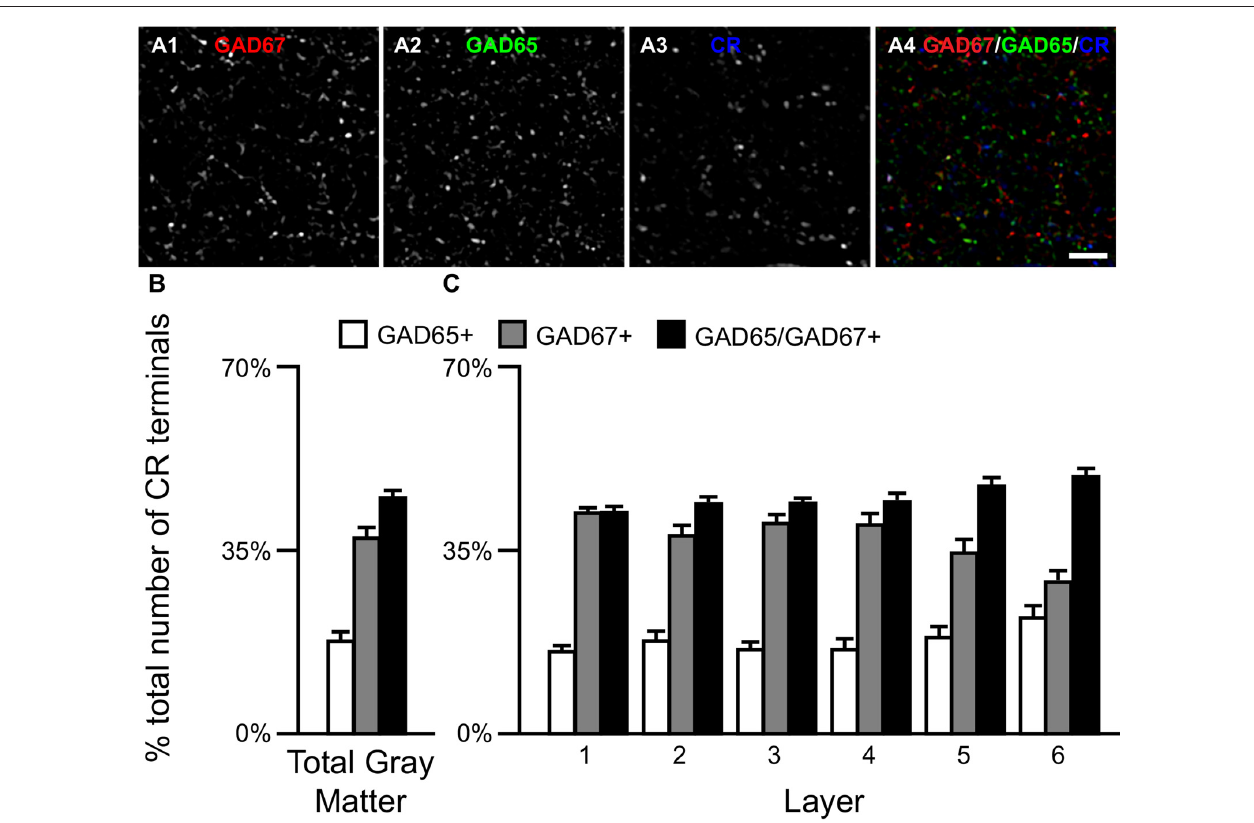
FIGURE 4 | The proportion of three CR/GAD+ terminal subpopulations differs across cortical layers. (A) Projection image (7 z-planes separated by 0.25 µ m) of a human PFC tissue section immunolabeled for CR, vGAT (not shown), GAD65 and GAD67. Gray scale images (A1–A3) are single channel images of the multichannel image (A4) and are representative of the immunohistochemistry labeling. Scale bar = 5 µ m. (B,C) Bar graphs showing the relative proportions of vGAT/CR+ terminals in PFC that were GAD65+, GAD67+, or GAD65/GAD67+. Error bars =